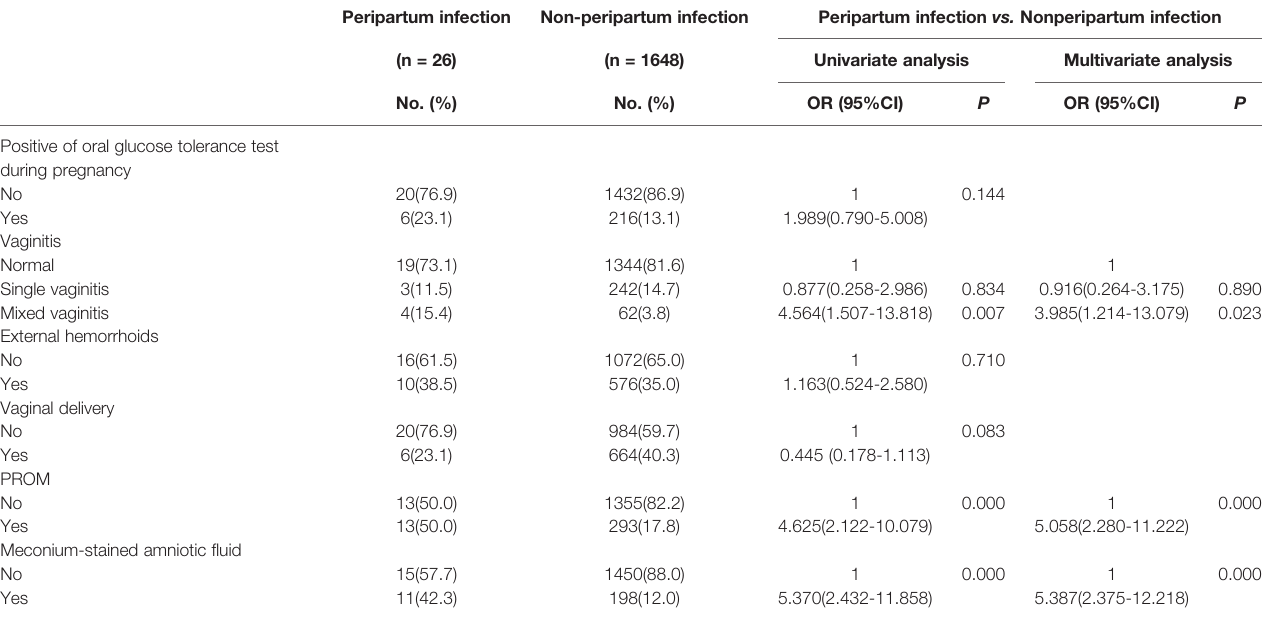
TABLE 5 | Risk factors associated with peripartum infection.